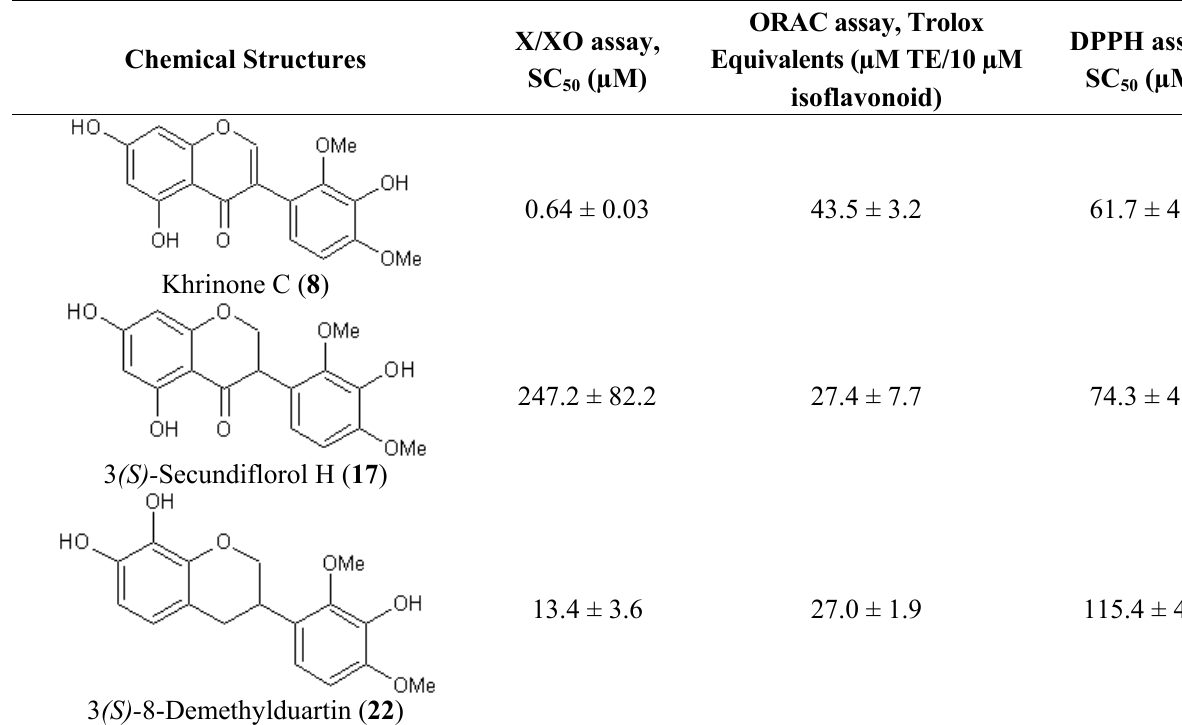
Table 2. Comparison of three isoflavonoids with the same substitution but belonging to different subgroups: the isoflavone khrinone C, the isoflavanone 3 (S)- secundiflorol H, and the isoflavan 3 (S)-